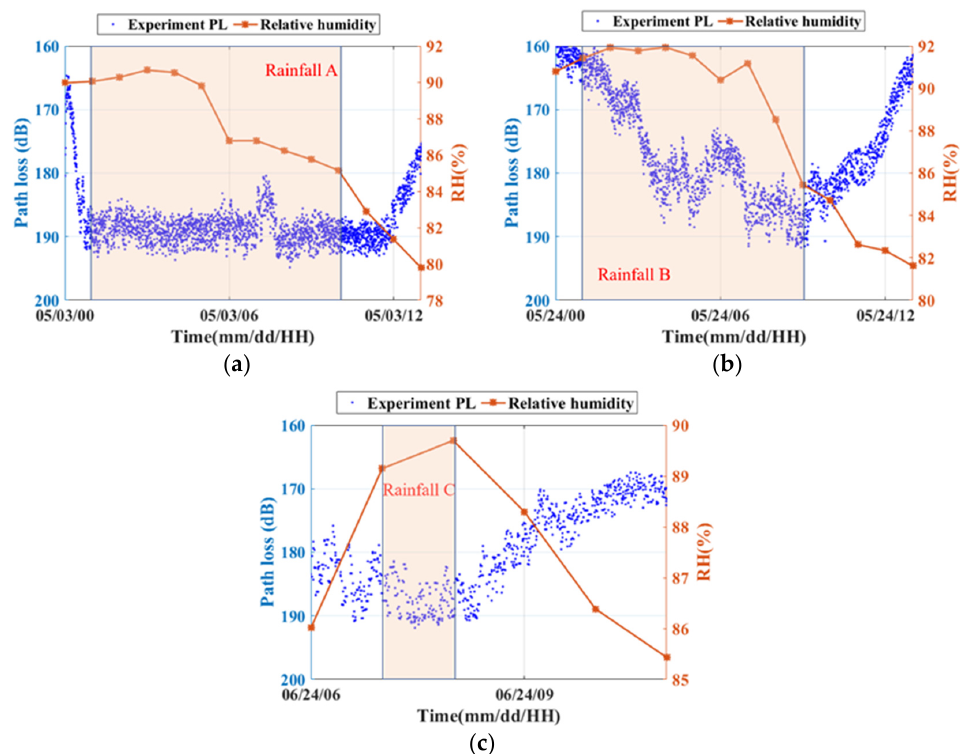
Figure 21. The additional experiment results of PL in 2021. ( a ) 3 rd May, ( b ) 24 th May, ( c ) 24 th ,